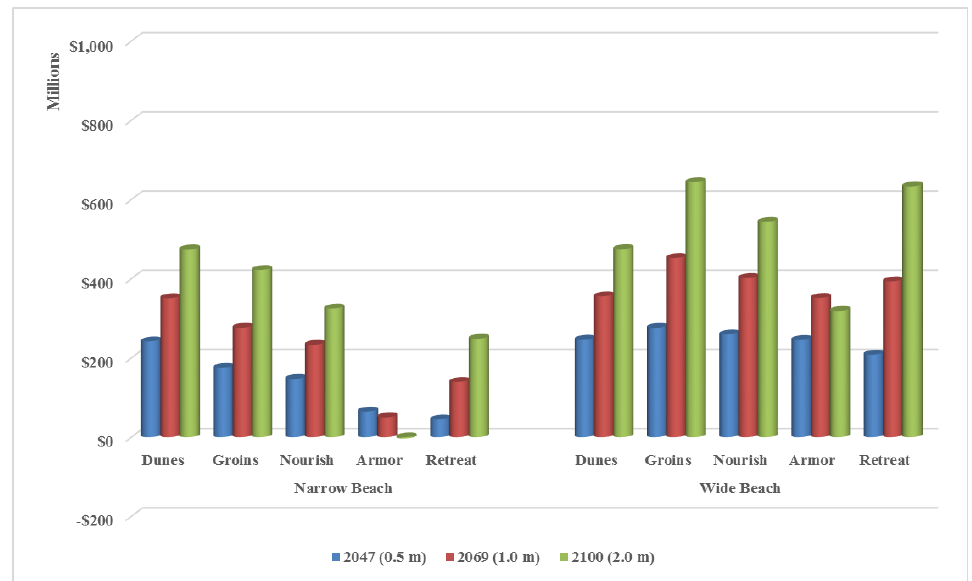
Figure 16. Net benefits of the selected adaptation alternatives over time for both a narrow beach ( left ) and a wide beach ( right ). Table 6. Results of Sensitivity Analysis.